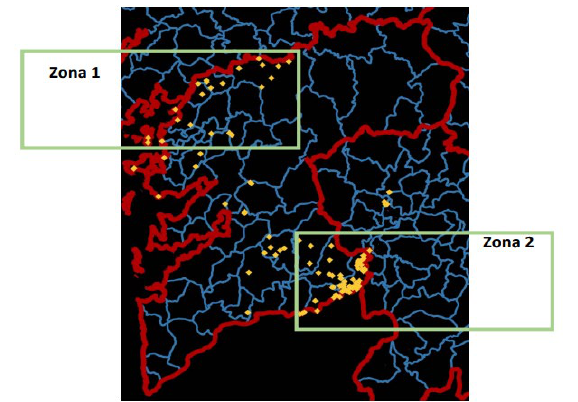
Figure 11 Results of detection based on the spectral distance of the estimator